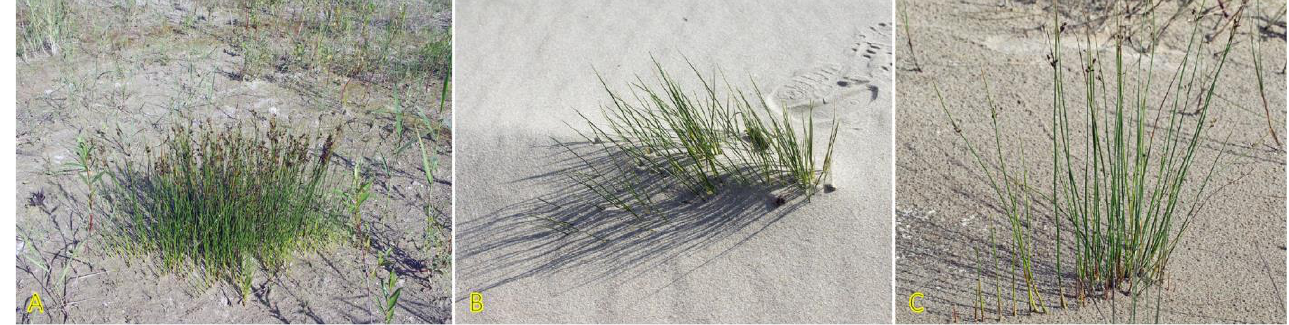
Figure 13. Genets of Juncus balticus on a wet beach in Lielupe, Jūrmala, Latvia ( A ), on embryonic dunes in Ovīši, Latvia ( B ), on a wet beach in Vaide, Latvia ( C ). dunes in Ov¯ıši, Latvia ( B ), on a wet beach in Vaide, Latvia ( C